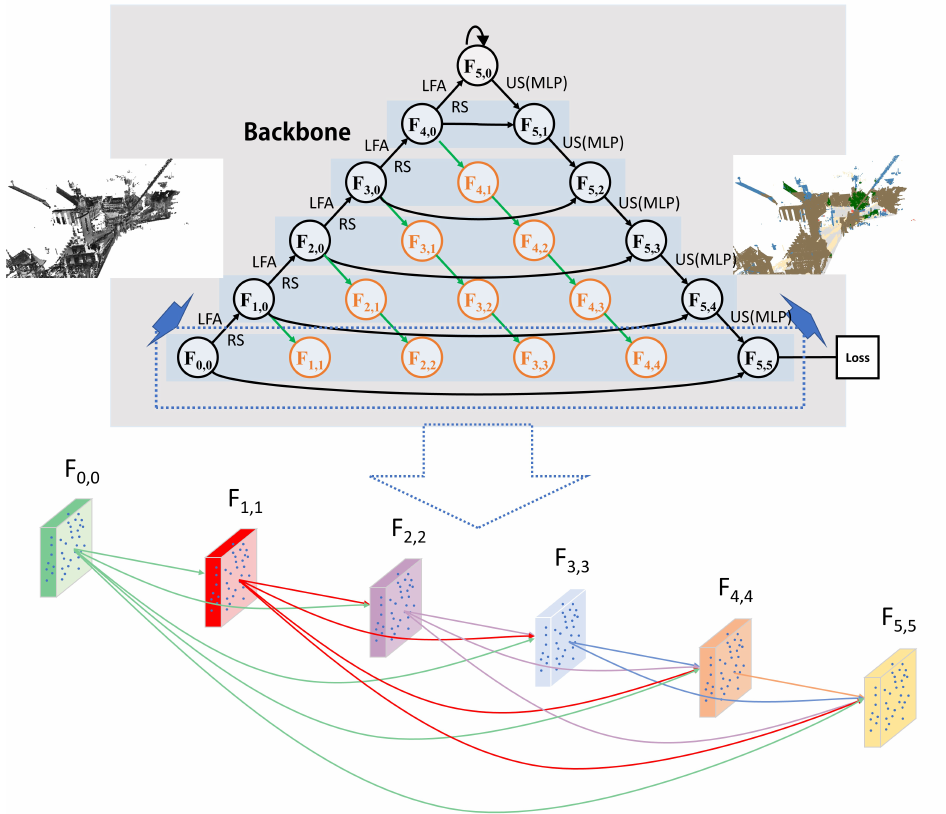
Figure 2. Multiple encoder–decoders are concatenated together to form the main structure of feature fusion. Features in the same blue rectangular block are fully fused by skip